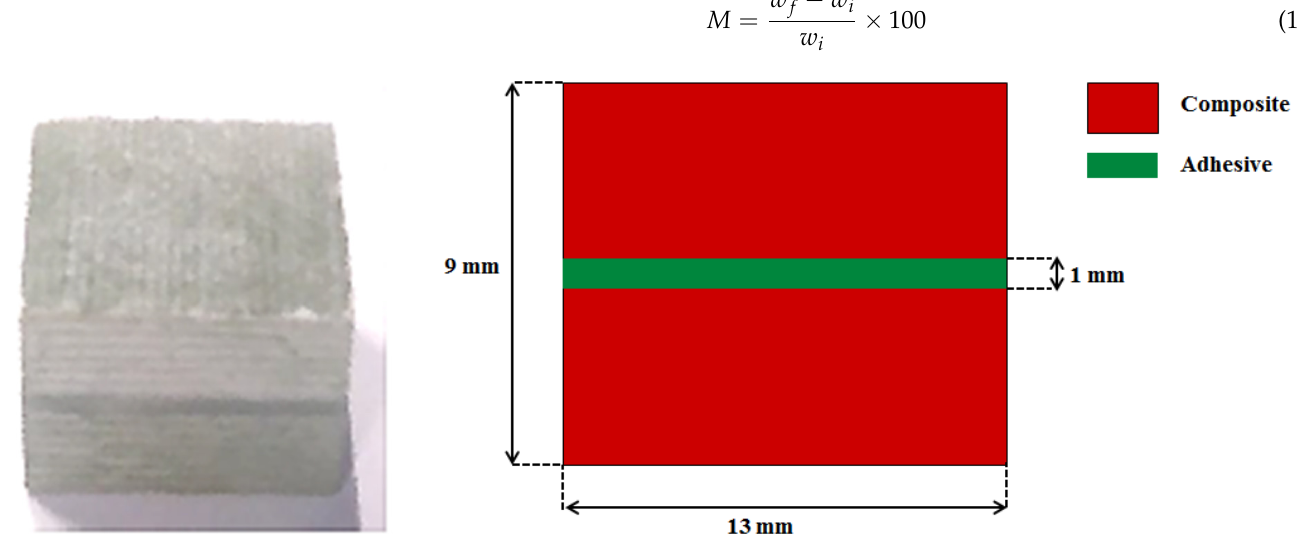
Figure 1. Adhesively bonded composite joints sample.